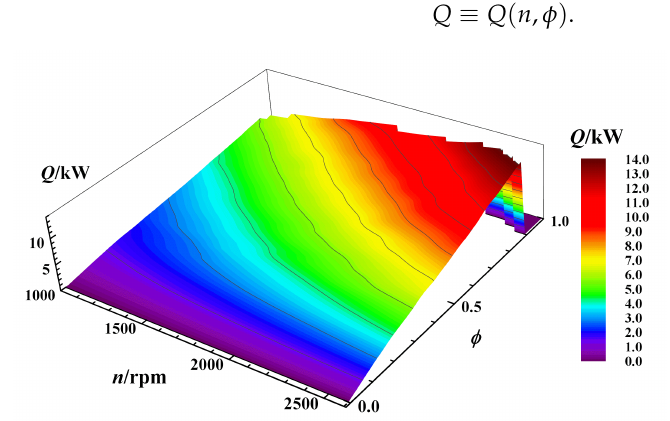
Figure 2. Map of heat rejection of the DK32